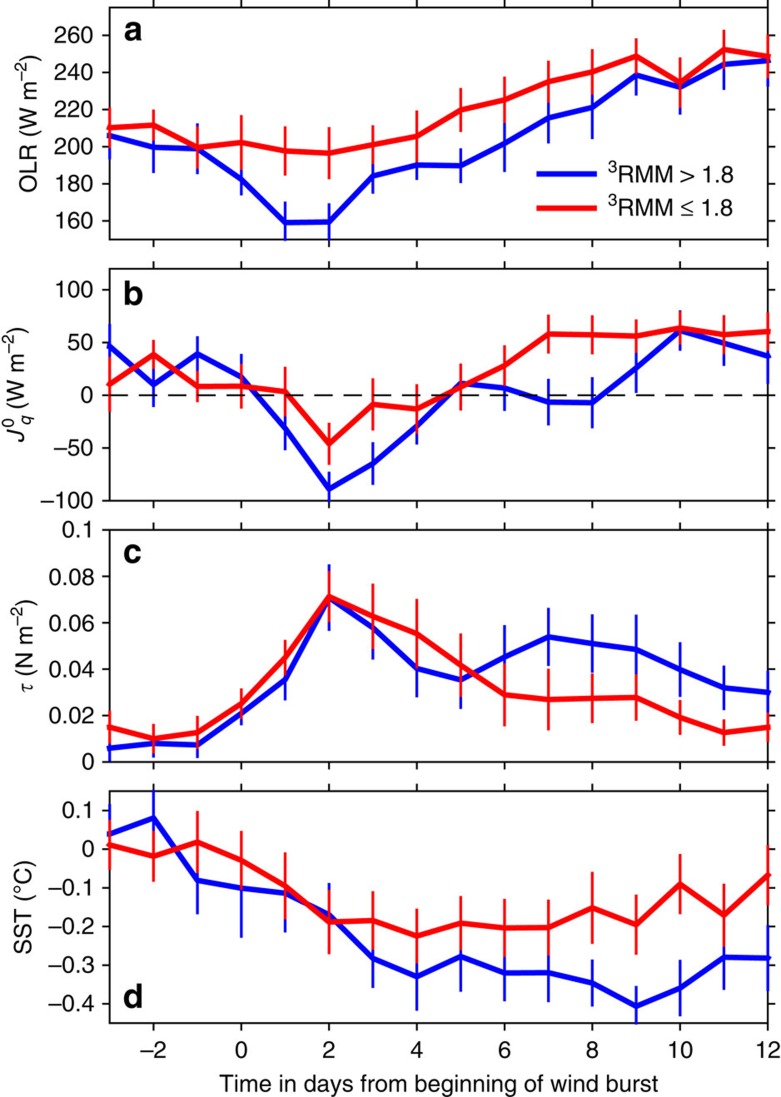
Composite averaged temporal evolution of paired pulses.The pairs are separated by<55 days, as identified in the text. Ensemble averages derived from 18 weak (1<3RMM<1.8; red) and 18 strong pulses (3RMM>1.8; blue). Time is referenced to the principal wind burst of each pulse. (a) Outgoing longwave radiation, OLR. (b) Net surface heat flux, . (c) Surface wind stress, τ. (d) Sea surface temperature, SST. The vertical bars represent 95% bootstrap confidence limits.